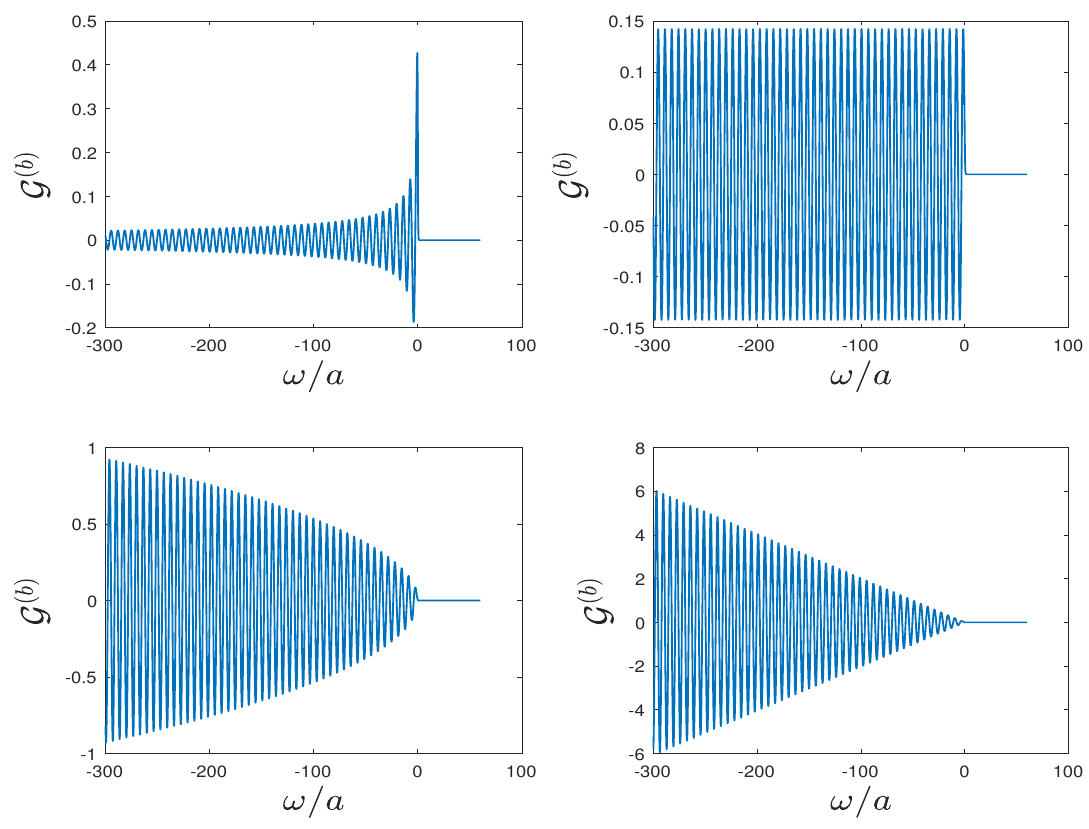
Figure 2 . Behavior of G ( b ) in different spacetime dimensions. The four subfigures stand for D = 3 , D = 4 , D = 5 , D = 6 respectively from left to right and top to